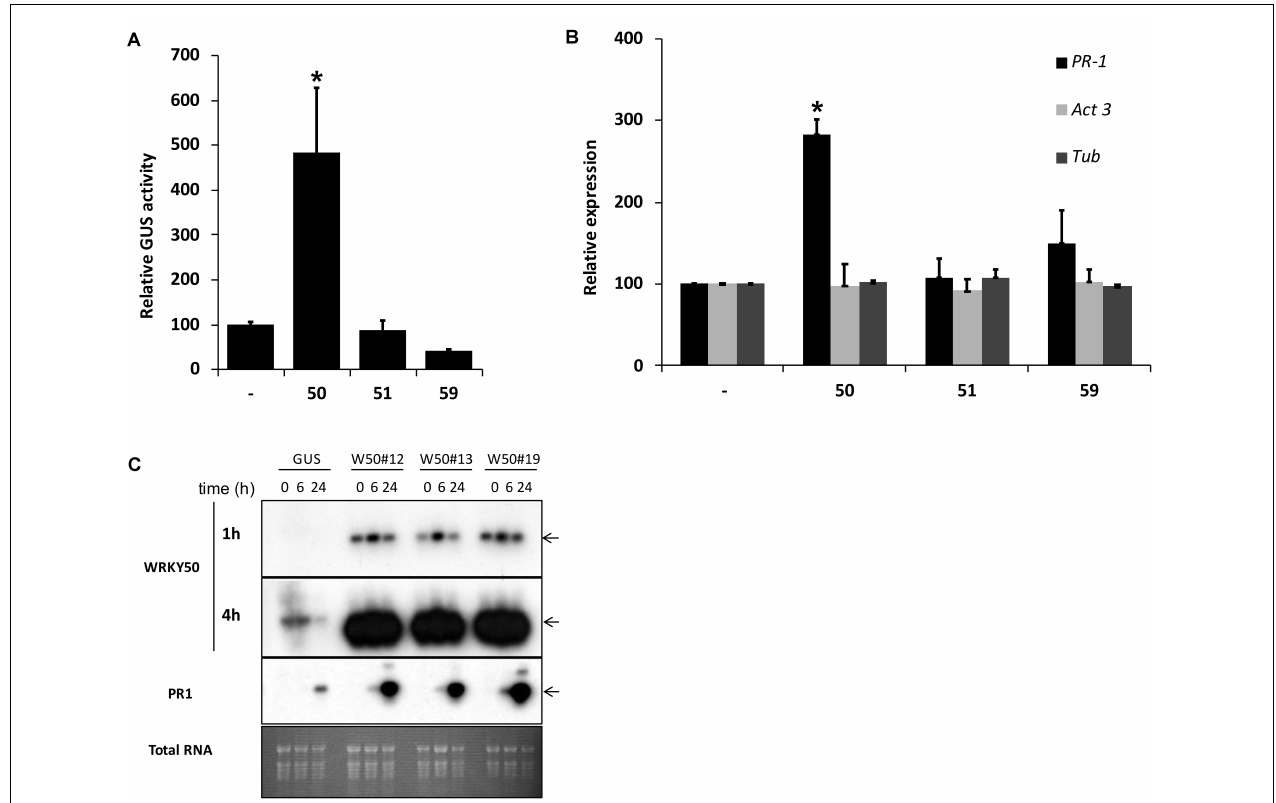
FIGURE 1 | (A) AtWRKY50 activates the PR1 promoter. Arabidopsis protoplasts were co-transfected with a PR1::GUS construct together with empty pRT101 expression plasmid (minus sign) or with plasmids containing 35S::AtWRKY50 (50), 35S::AtWRKY51 (51) or 35S::AtWRKY59 (59). After incubation, GUS activity was measured spectrophotometrically. Expression levels (%) are given relative to the expression level without WRKY effector. (B) Effect of AtWRKY50, AtWRKY51, and AtWRKY59 on the expression of endogenous Arabidopsis genes. Expression of PR1 , Act3 (actin) and Tub (tubulin) genes in Arabidopsis protoplasts was measured by qRT-PCR. Expression of each gene was measured in protoplasts transfected with the empty pRT101 vector (minus sign) or with the pRT101 vector containing the 35S::AtWRKY50 (50), 35S::AtWRKY51 (51), or 35S::AtWRKY59 (59) expression constructs. Bars represent the average level of mRNA accumulation observed in three experiments. mRNA levels in protoplasts transfected with the empty pRT101 vector were taken as 100%. Error bars represent the SEM. The experiment was repeated three times with similar results. Statistical differences among the samples is labeled with asterisk ( p < 0.05). (C) Overexpression of AtWRKY50 enhances SA-induced expression of PR1 in plants. Three lines of transgenic seedlings overexpressing AtWRKY50 (W50#12, #13, #19) and a line expressing GUS were incubated for the indicated times (in hours) in liquid medium containing 0.3 mM SA, after which RNA was extracted and analyzed for accumulation of mRNA corresponding to genes AtWRKY50 and PR1 . The blot hybridized with the AtWRKY50 probe was exposed for 1 and 4 h. A similar blot was hybridized with the PR1 probe. Arrows to the right of the blots indicate the expected positions of the respective mRNAs as deduced from the positions of the rRNAs. An Ethidium bromide stained gel showing total RNA is included as a loading